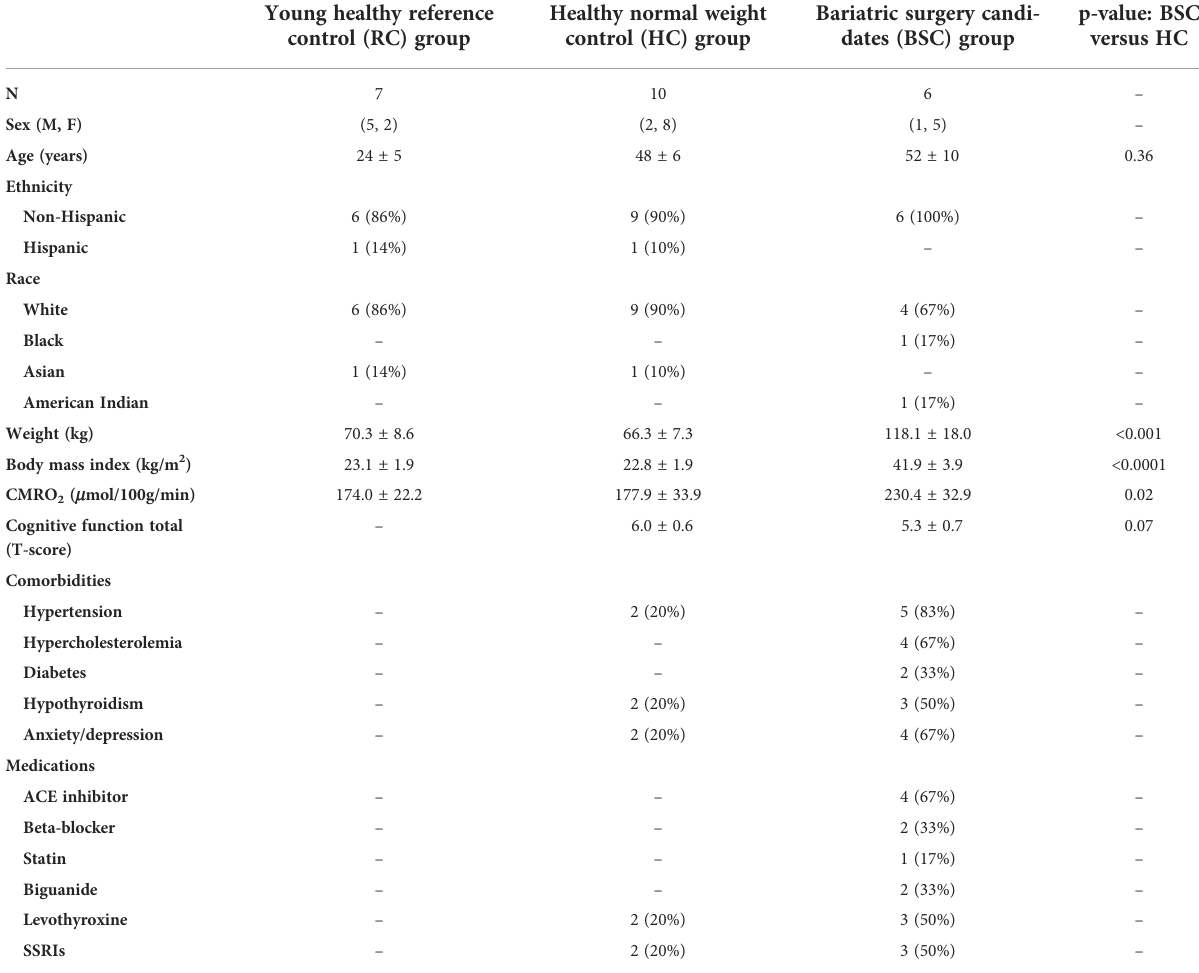
Values are mean ± standard deviation; “ - ” : test not done or data not group. Please refer to Table 2 for global CMRO 2 and the associated global CBF and OEF in HC and BSC groups.